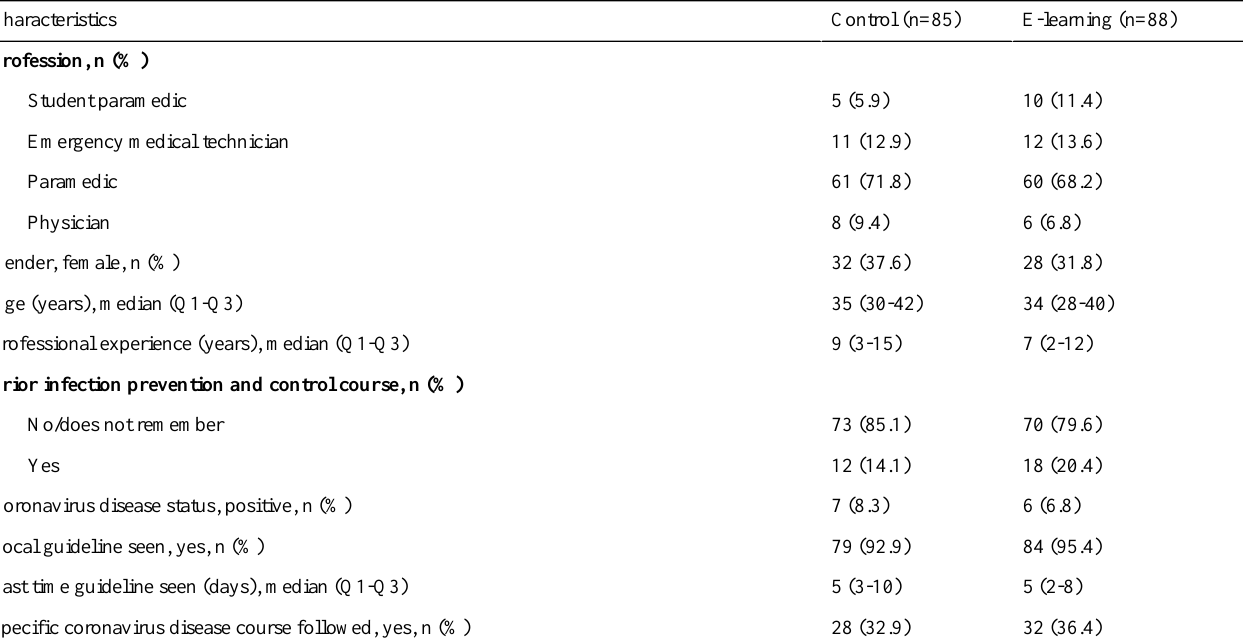
E-learning (n=88)Control